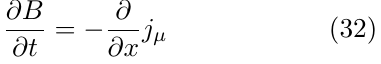
Figure 3. Normalized magnetic field profiles developed by SDIM-1 for dif- ferent values of the parameter m of the surface ramping magnetization: a) SDIM-1 solution with stipulated parabolic profile exponent n = 2; b, c) SDIM-1 solutions with optimal ex- ponents: Comparison with exact so- lutions (tabulated) from [13] 1. SDIM-1:Optimal expo- nents for different values of